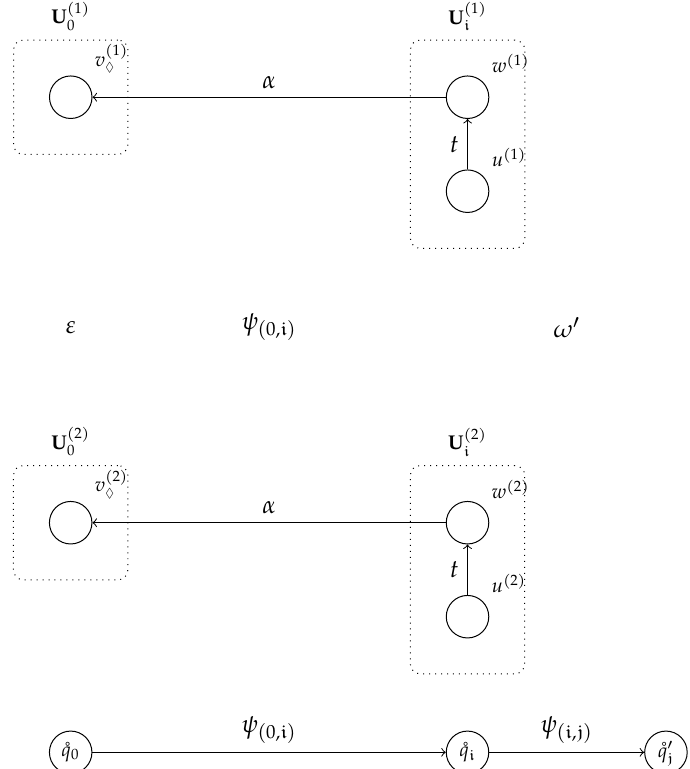
Figure 26. The relevant part of Γ p 1 q after the ε -reduce action is performed by the character-level RNGLR and the corresponding part of Γ p 2 q after the ε -shift action is performed by our architecture. This exhausts all possible combinations of actions, where X the statement holds for all paths ι . Γ p 2 q indeed contains all paths labeled ι in Γ p 1 q